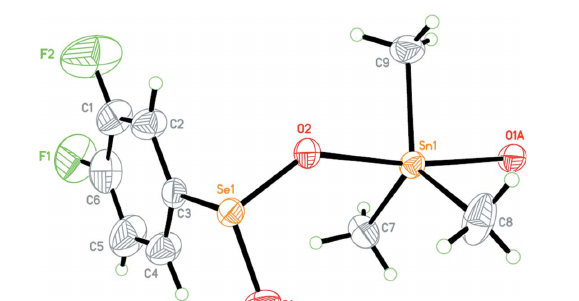
Figure 1 The coordination environment of the Sn IV atom, showing displacement ellipsoids at the 30% probability level. [Symmetry code: (A) (cid:3) x + 1 (cid:3) z + 3